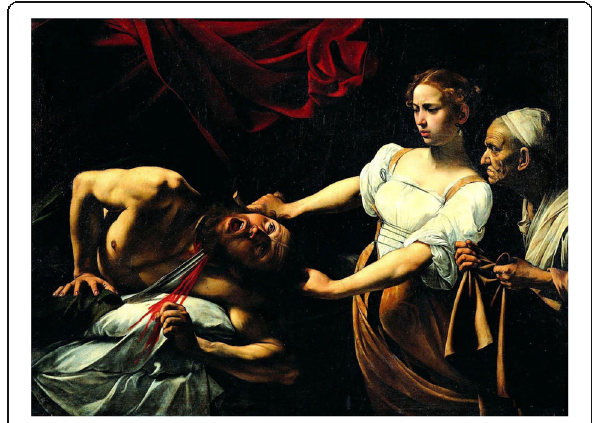
Fig. 1 “ Judith Beheading Holofernes ” (1599). (Available from https://commons.wikimedia.org/w/index.php?curid=10774618)